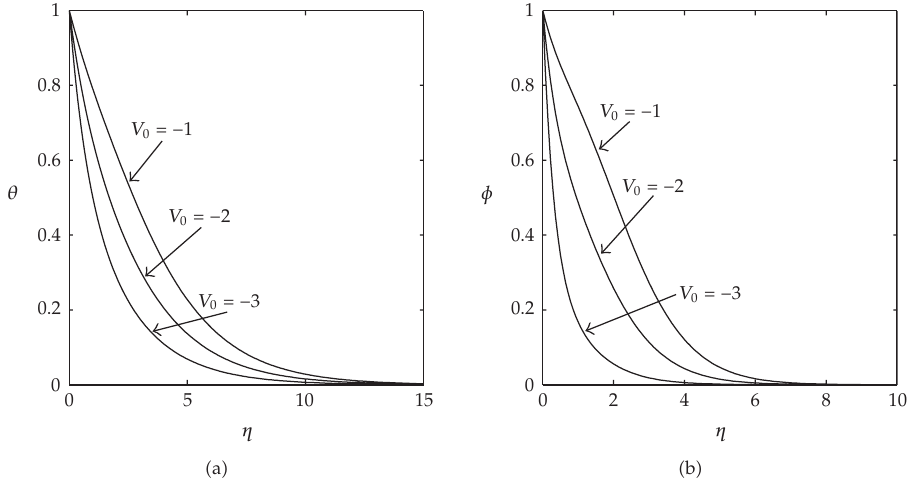
Figure 3: The variation of (cid:8) a (cid:9) the temperature distribution and (cid:8) b (cid:9) the concentration profiles with increasing injection parameter numbers with ξ (cid:7) 5 , Gr (cid:7) Gr c (cid:7) 1 , Pr (cid:7) 0 . 72 , Sc (cid:7) 1 , R (cid:7) 1 .